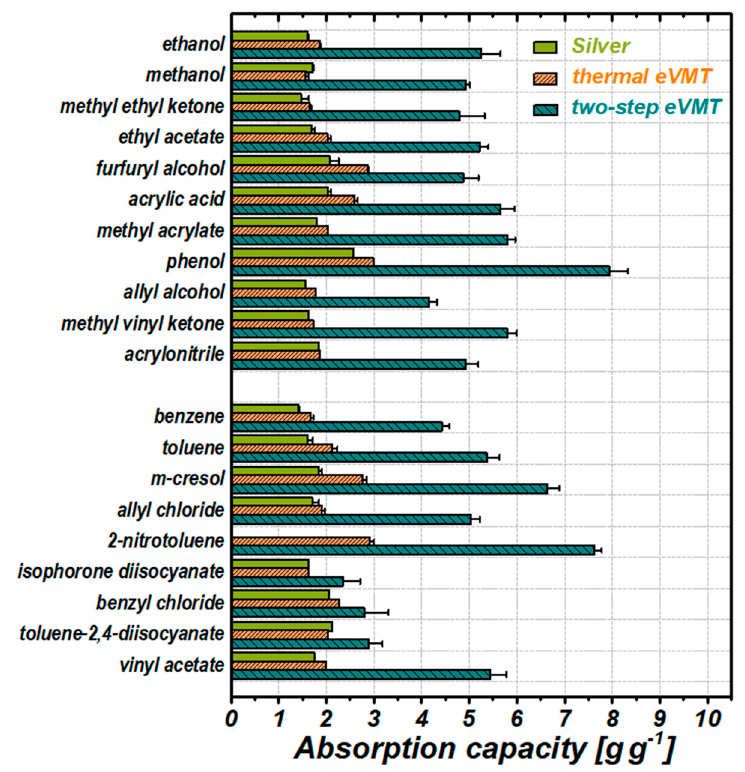
Figure 7. Horizontal bar charts displaying the absorption capacities of three different eVMTs for various hazardous liquid chemicals. The error bars were obtained using three measurements.